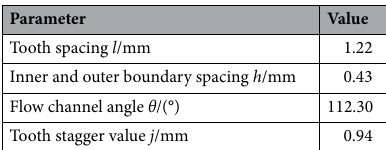
Table 3. Optimization results of the structural